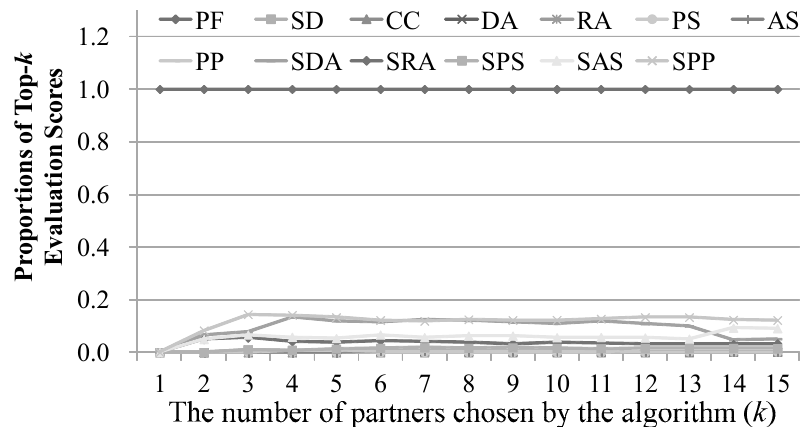
Figure 11. Proportions of top- k evaluation scores among results of various methods.